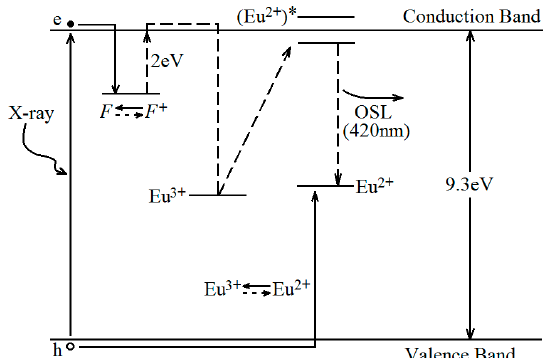
Figure 13. Energy-band diagram at KCl:Eu 2 + phosphor crystal for excitation and emission mechanism in X-ray irradiated specimen.